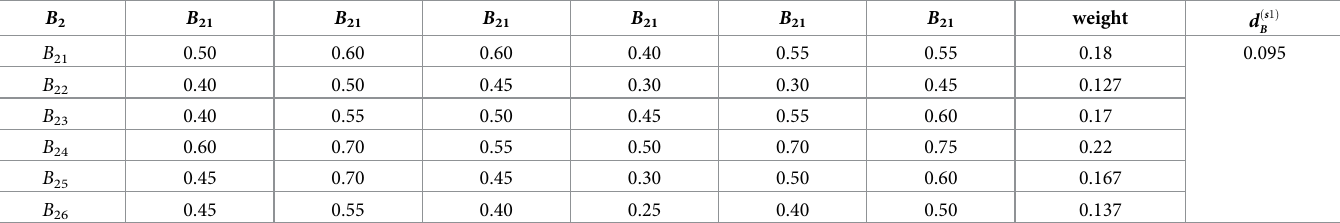
of expert s 1. B